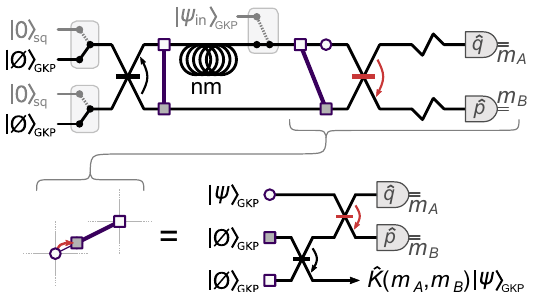
FIG. 3. Implementation of GKP quadrature correction by , are injected into qubit teleportation. Qunaught states, | ∅ (cid:2) GKP the resource-preparation gadget, thereby preparing a two-mode GKP-qubit Bell state, shown as two connected rectangles before the nm delay. In the computational level, after the nm delay, one part of the Bell state overlaps in time with the GKP-qubit state , shown as a circle. When the TDMD to be corrected, | ψ (cid:2) GKP